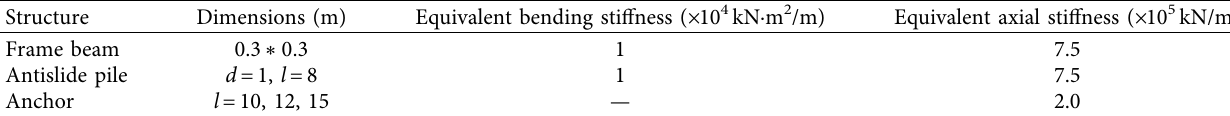
Table 2: Parameters of frame beam, anchor, and antislide